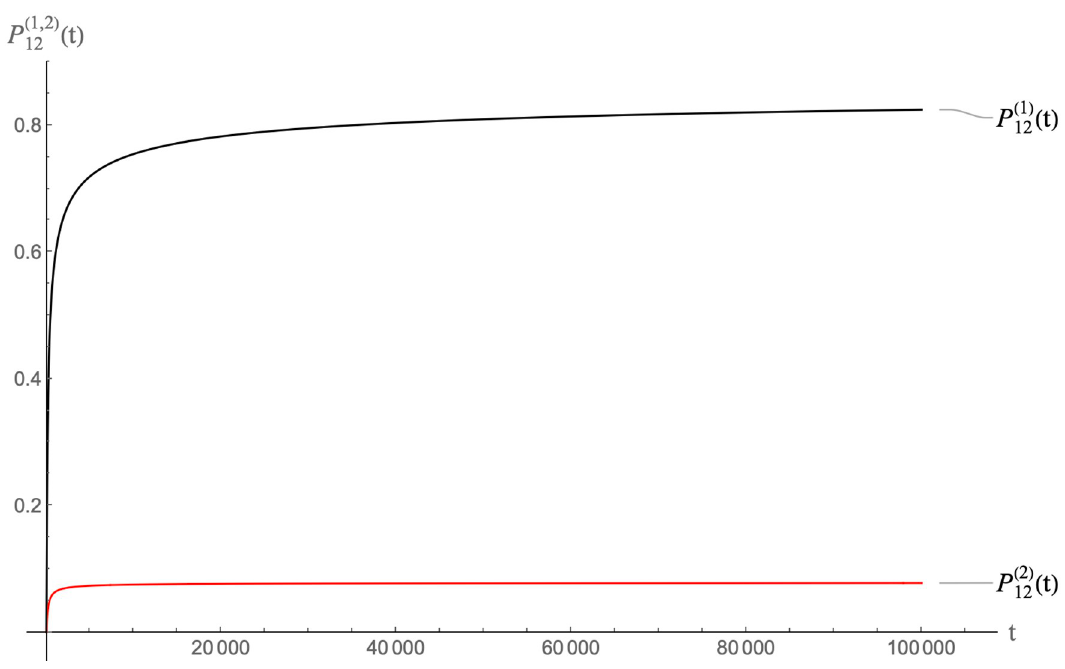
Fig 12. Same as the previous figure but on a time scale of 10 4 units.